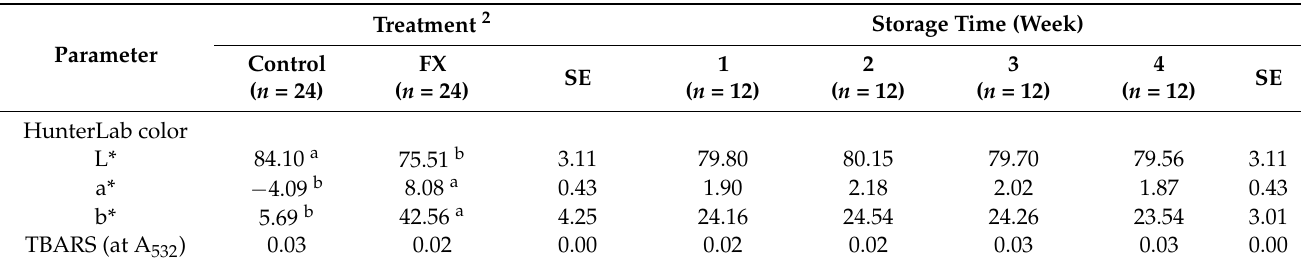
Table 7. Effect of fucoxanthin supplementation on color and lipid oxidation 1 of goat skim milk during storage (4 ◦ C). Treatment 2 Storage Time Parameter